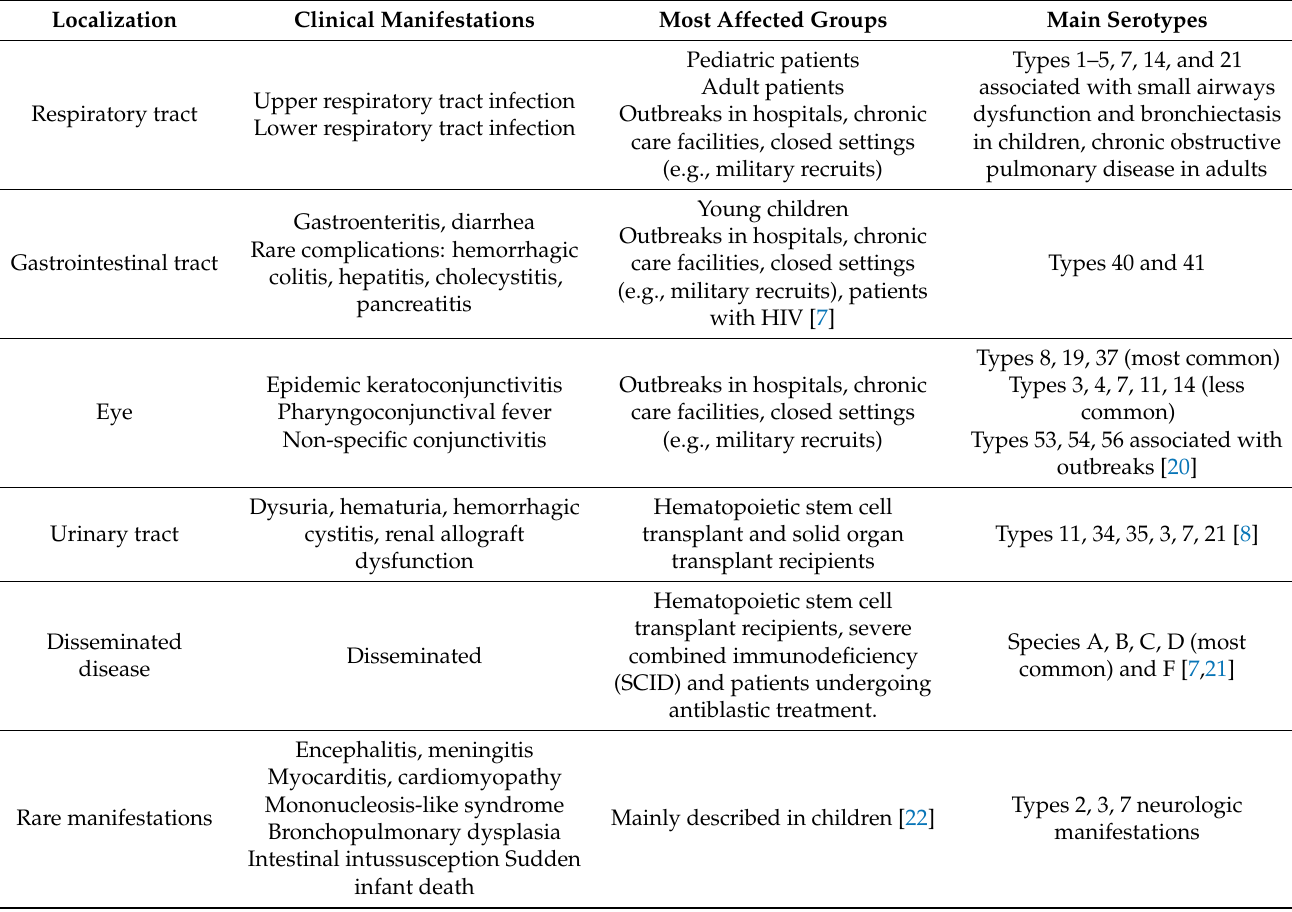
Table 1. Common associations between general infection sites and HAdV types. Other HAdV species may also occur at the site of infection. Many HAdV species show great variability in their tissue